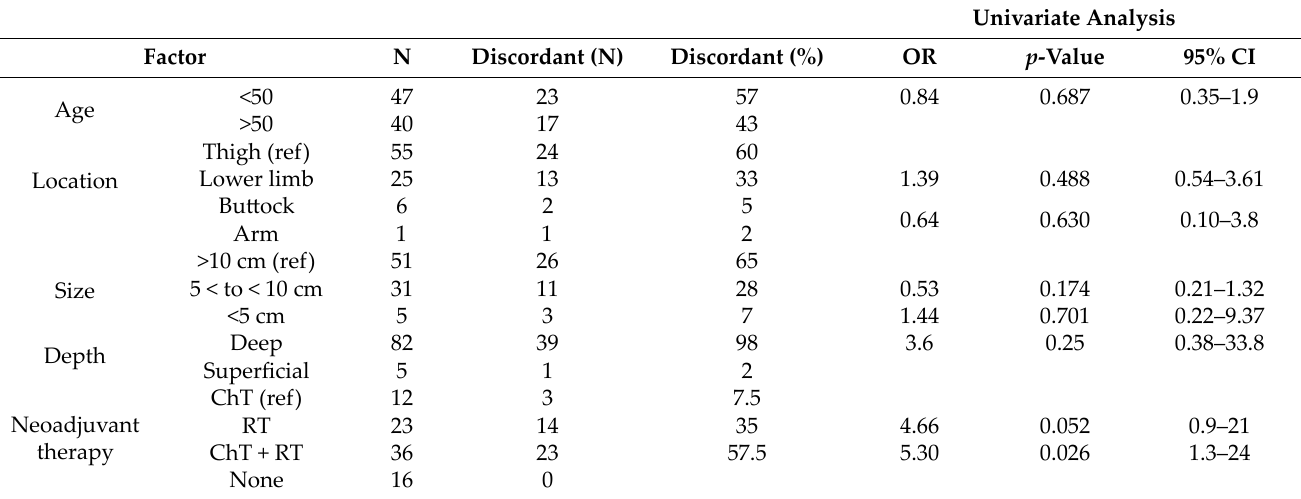
Table 3. Factors Correlated to Histological Downgrading Limited to Group A.